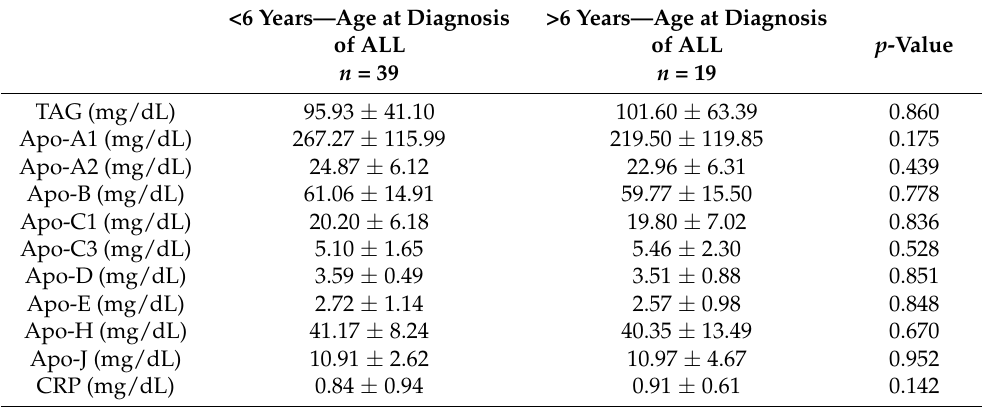
Table 3. Characteristics of patients with acute lymphoblastic leukemia (ALL) according to age at diagnosis. Data are presented as the mean ± standard deviation (SD).